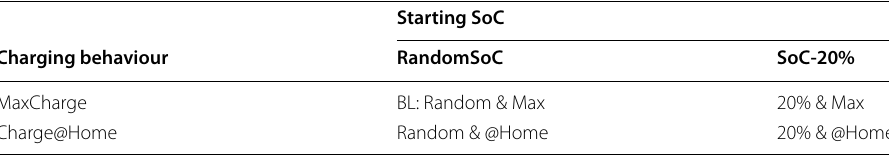
Table 2 Overview of the scenarios—correct template